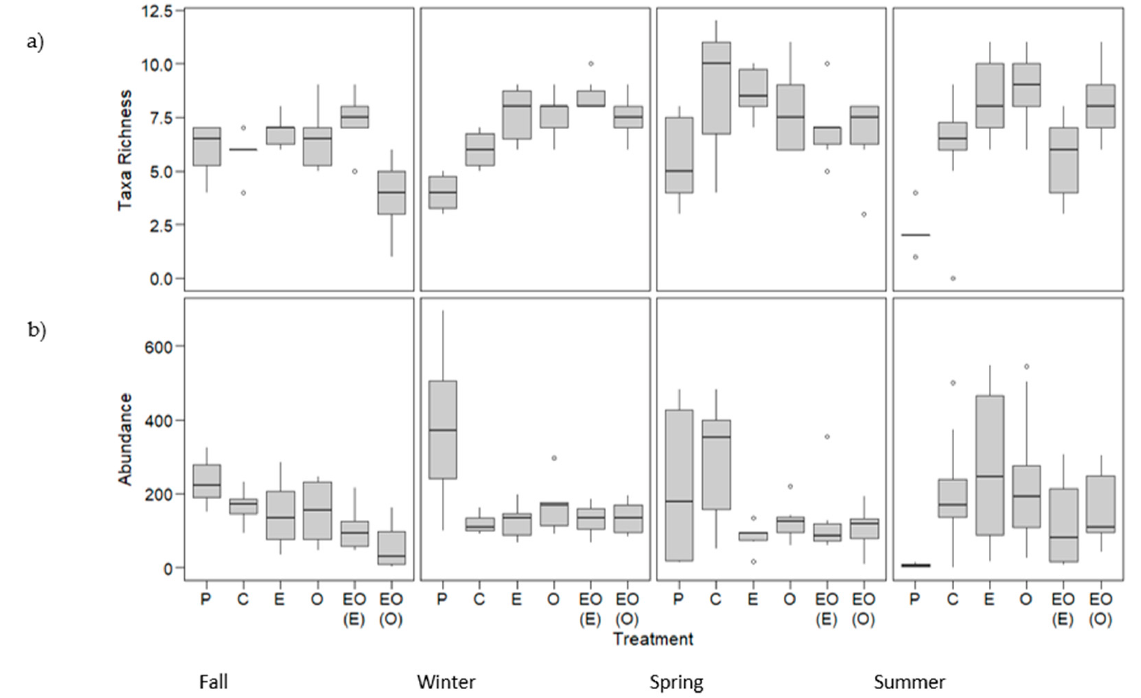
Figure A2. Taxa richness ( a ) and total abundance ( b ) of suction-sampled invertebrates by season. Each season contains one pre-treatment sampling period compared to a corresponding post-treatment period (for fall, pre was 2011 and post was 2014; for winter and spring, pre was 2012 and post was 2014; for summer, pre was 2012 and post was 2013, 2014, and 2015). Treatments included: P = pre-treatment, C = control, E = eelgrass, O = oyster, EO(E) = eelgrass from combination plots, EO(O) = oyster from combination plots. Boxplot symbols as in Appendix A Figure A1.